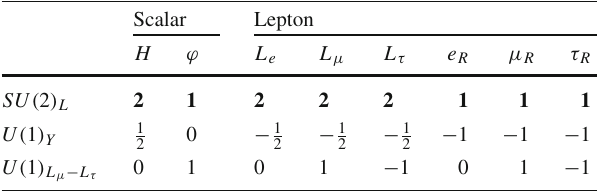
Table 1 Contents of scalar fields and their charge assignments under SU ( 2 ) L × U ( 1 ) Y × U ( 1 ) L μ − L τ Scalar